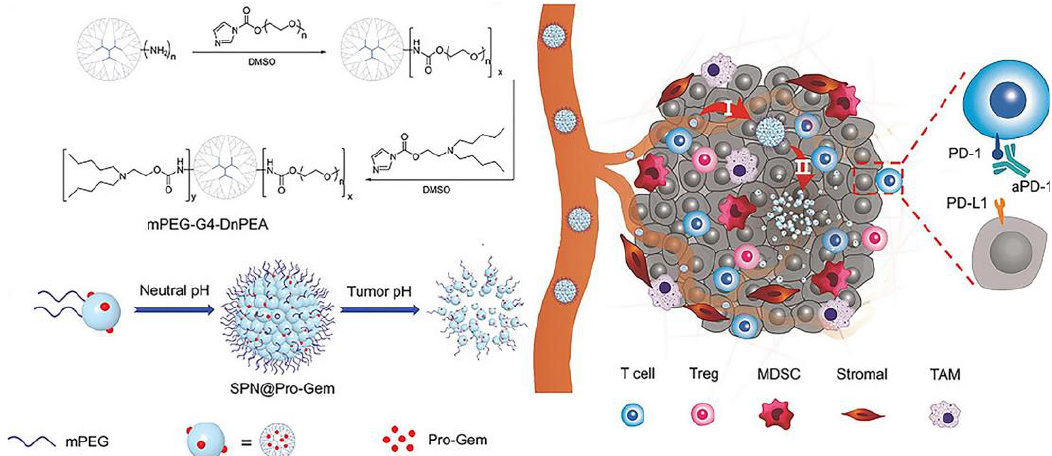
Figure 3. Scheme of the design and mechanism of the pH-sensitive size-transformable tumor-penetrating nanosystem SPN@Pro-Gem. Reprinted with permission from [110]. Copyright 2021, John Wiley and